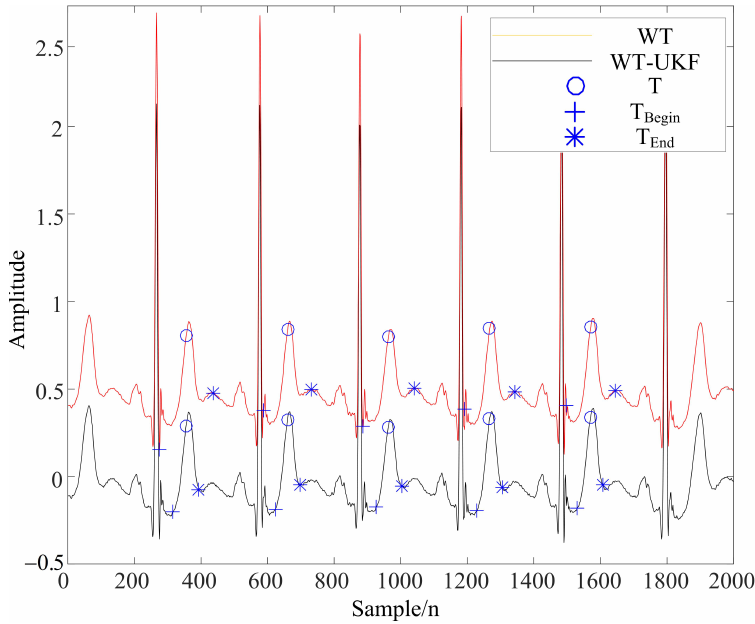
Figure 9. T-wave extraction results from the ECG signals of subject 103(MIT-BIH arrhythmia